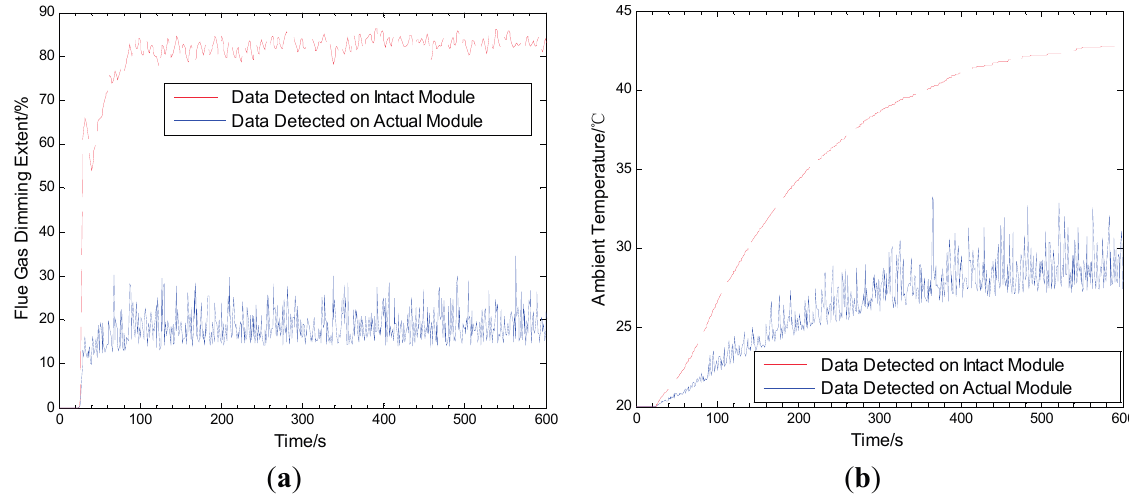
Figure 17. The real and detected average environmental parameters in fire. ( a ) flue gas dimming extent change; ( b ) ambient temperature change.